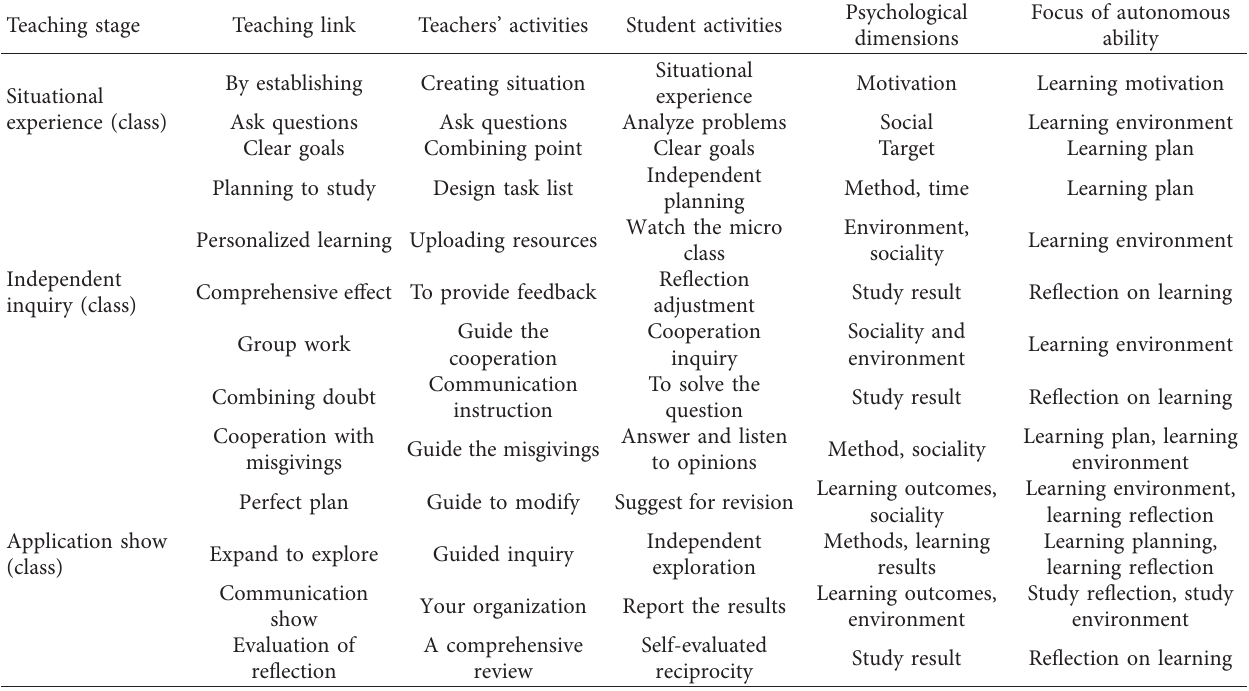
Table 3: Comparison table of flipped classroom teaching strategy and autonomous learning process.